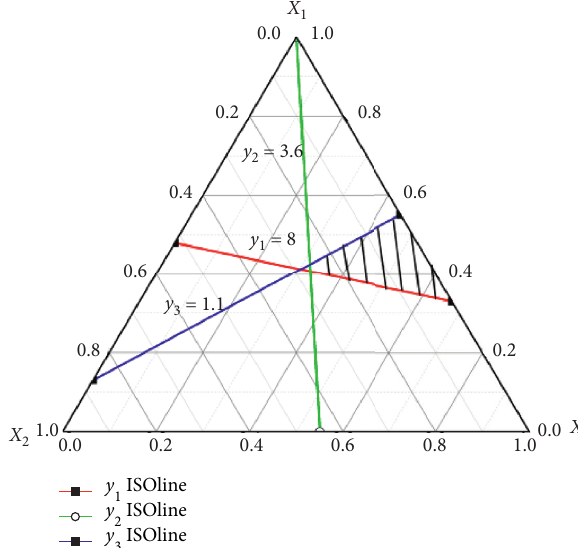
3 regression equation.